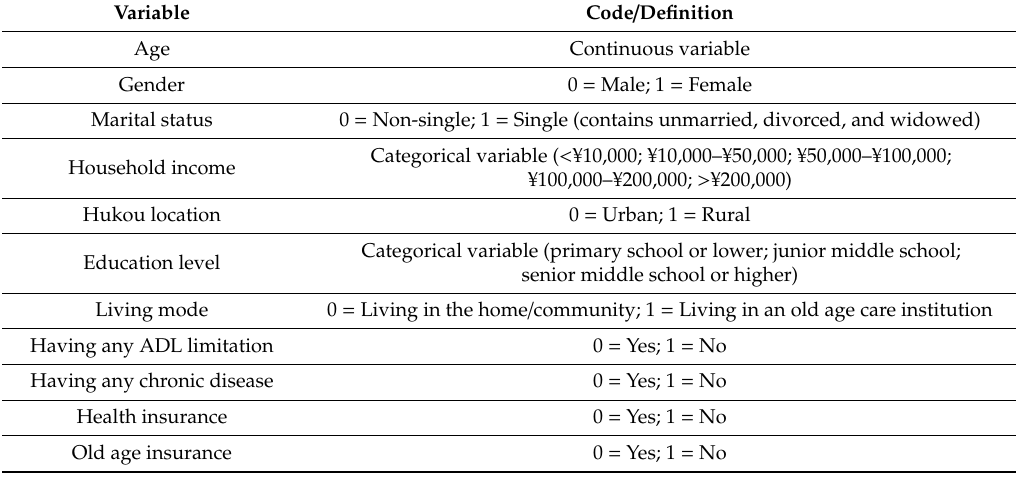
Table 1. Definition / codes of the sociodemographic